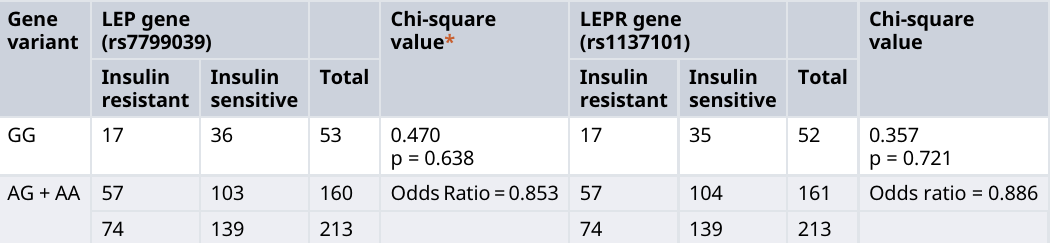
Table 3. Association between leptin gene and leptin receptor gene polymorphism in insulin resistant and insulin sensitive pregnant women. Gene LEP gene variant (rs7799039)